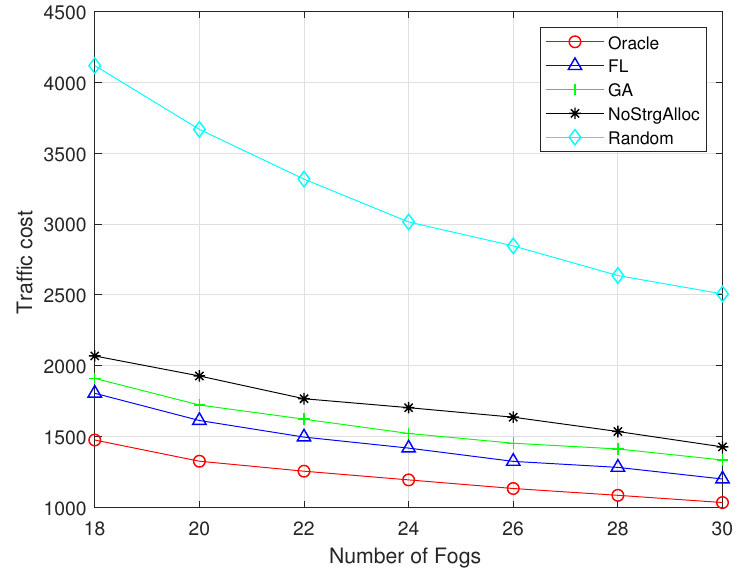
Figure 9. Traffic cost vs number of Fogs (MovieLens 100K).